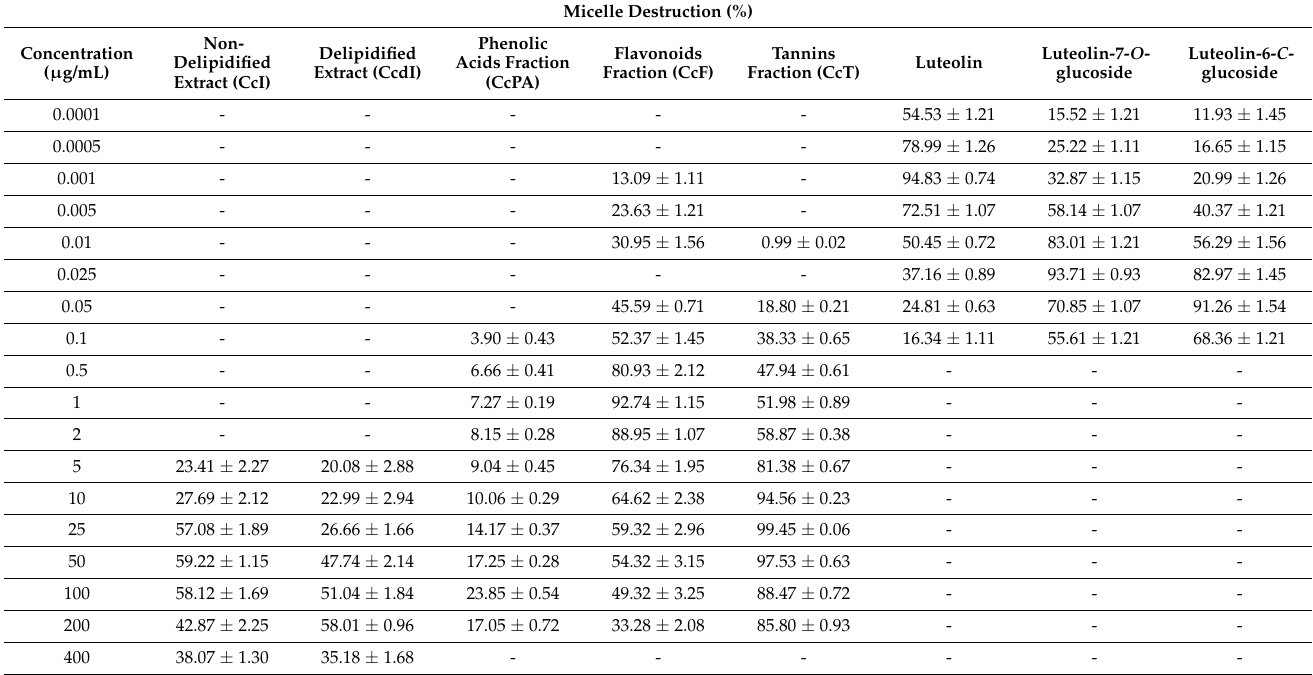
Table A1. In vitro cholesterol micellar solubility assay of Cymbopogon citratus infusions, phenolic fractions and flavonoid standards. The tests were carried out in three independent assays and in triplicate for each independent assay. The results are expressed as mean ± standard